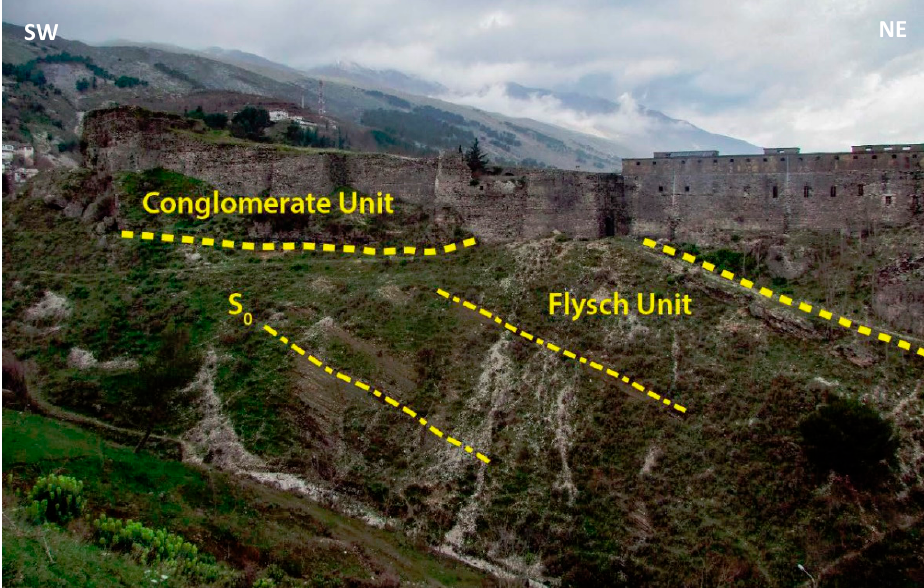
Figure 3. General overview of the southern part of the Gjirokastra castle showing the two geological units.